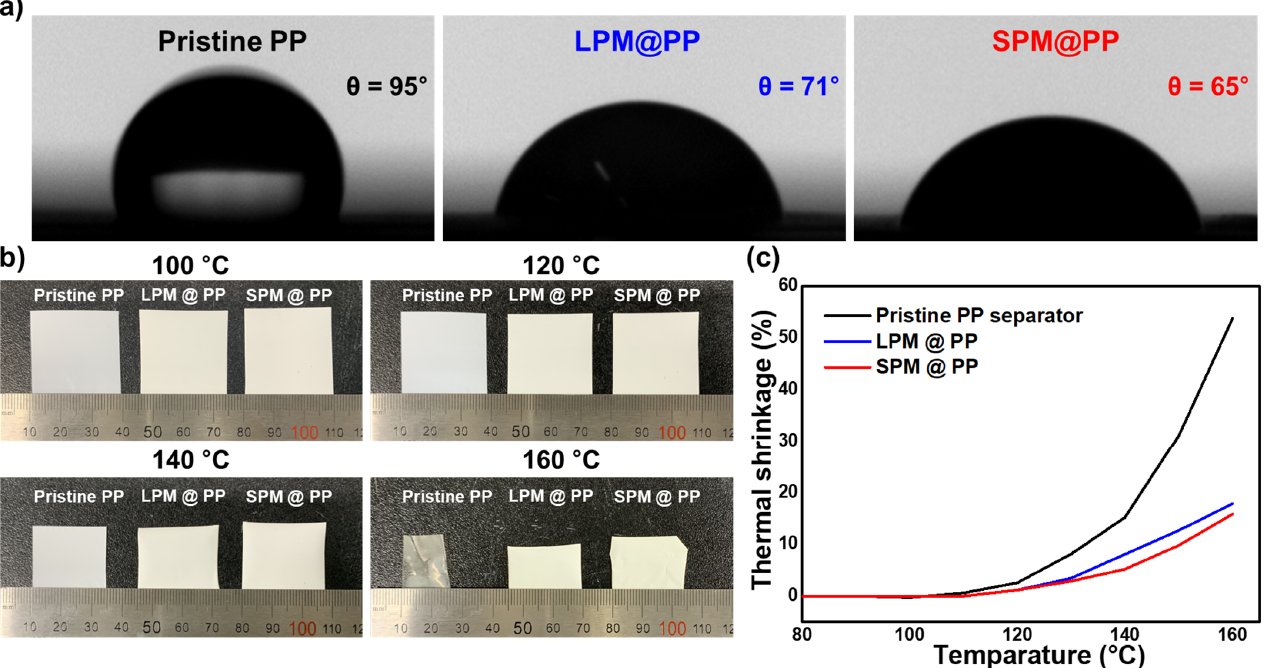
Figure 3. ( a ) Contact-angle measurements using a pristine PP separator, and the LPM- and SPM- coated separators. ( b ) Thermal shrinkage photographs at 100 °C, 120 °C, 140 °C and 160 °C; ( c ) Thermal shrinkage percentage of pristine of the pristine PP separator, and the LPM- and SPM-coated separators.